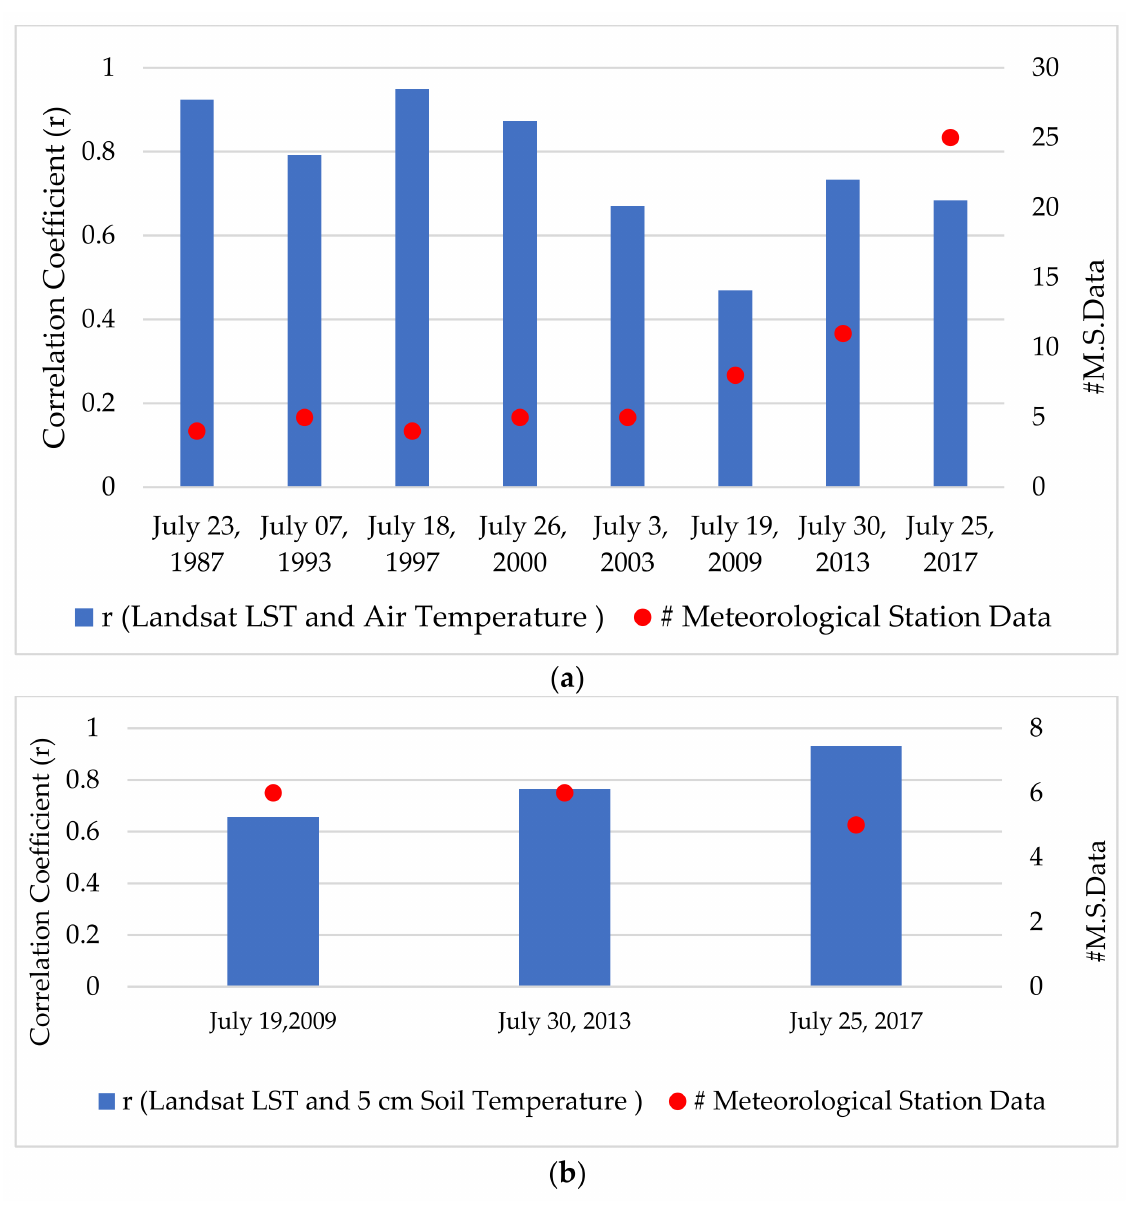
Figure 5. Correlation coefficients between Landsat LST and meteorological parameters (( a ) air temperatures, ( b ) 5 cm soil temperatures) and number of data measured at the